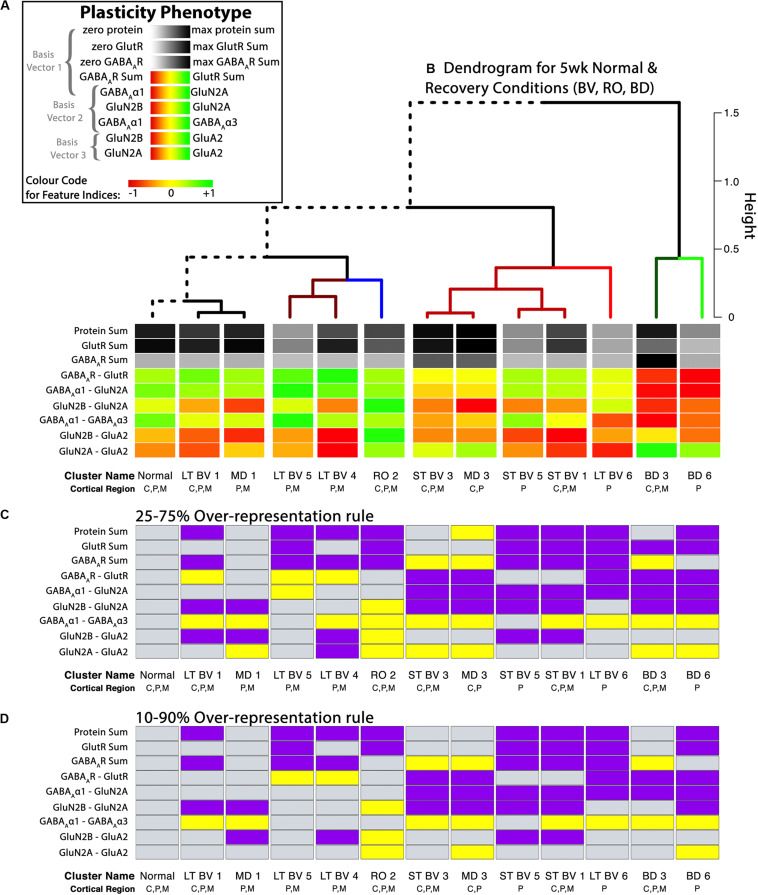
Analysis of plasticity phenotypes for the recovery treatment subclusters. (A) The color-code for each of the nine plasticity features. (B) The plasticity phenotypes for the 13 subclusters were ordered using the dendrogram that surrounds the correlation matrix in Figure 8. The rearing conditions (Normal, MD, RO, LT BV, ST BV) are described in Table 1. (C) Over-representation analysis (ORA) for each of the features in the treatment subclusters. With the first ORA (25–75%) bars were coded as over-represented (yellow) when the 25th percentile of the subcluster feature was greater than the 95th percentile of the normal distribution and under-represented (purple) when the 75th percentile of the feature was less than the 5th percentile of the normal distribution. That rule corresponds with the size of the boxplots in Figure 10. For the second ORA (D), a more conservative rule was applied that used the 10th and 90th percentile to identify over- or under-represented features in the treatment subclusters. Panel A is adapted from Balsor et al. (2019b), used with permission.